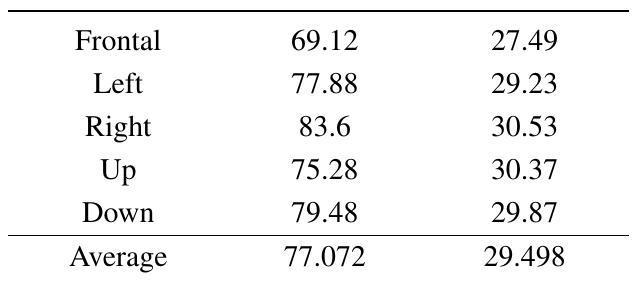
Table 3. Comparison of average number of iterations between general and proposed ICP.